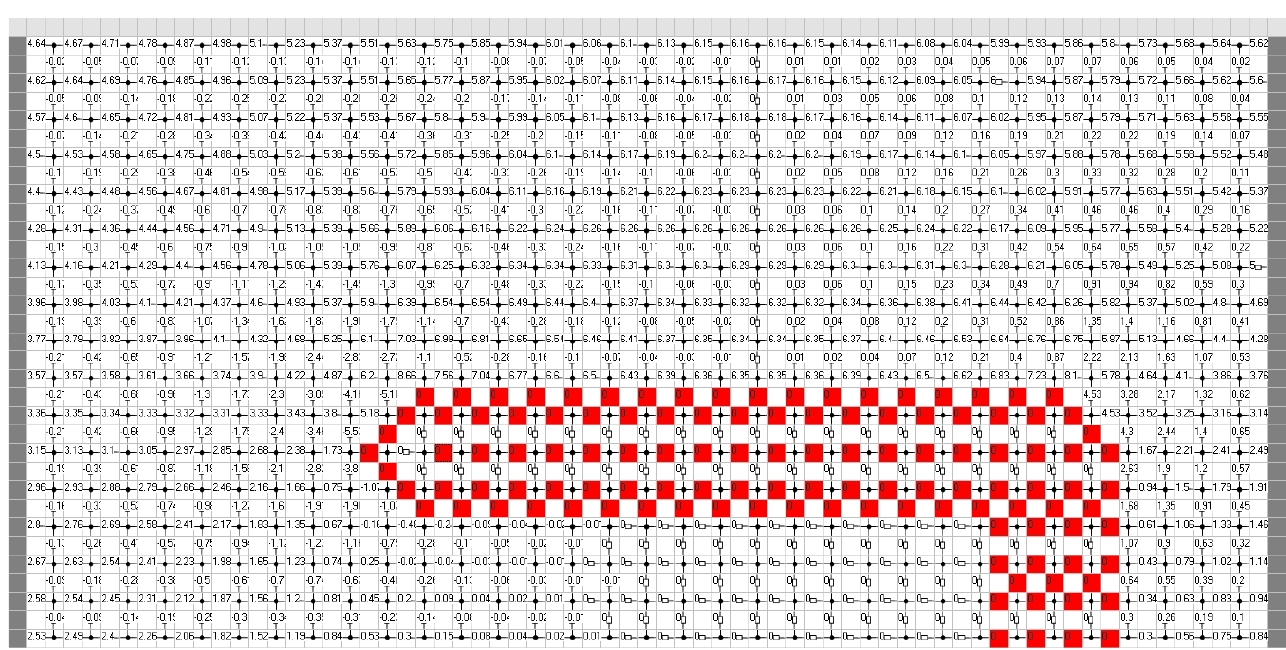
Figure 13. Distribution of currents over the grid branches after a laser trim.